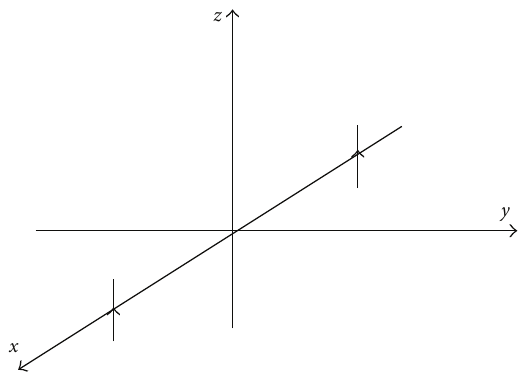
Figure 4: Two z -directed Hertzian dipoles on the x -axis at r 1 = ( − d/ 2,0,0) and r 2 = ( d/